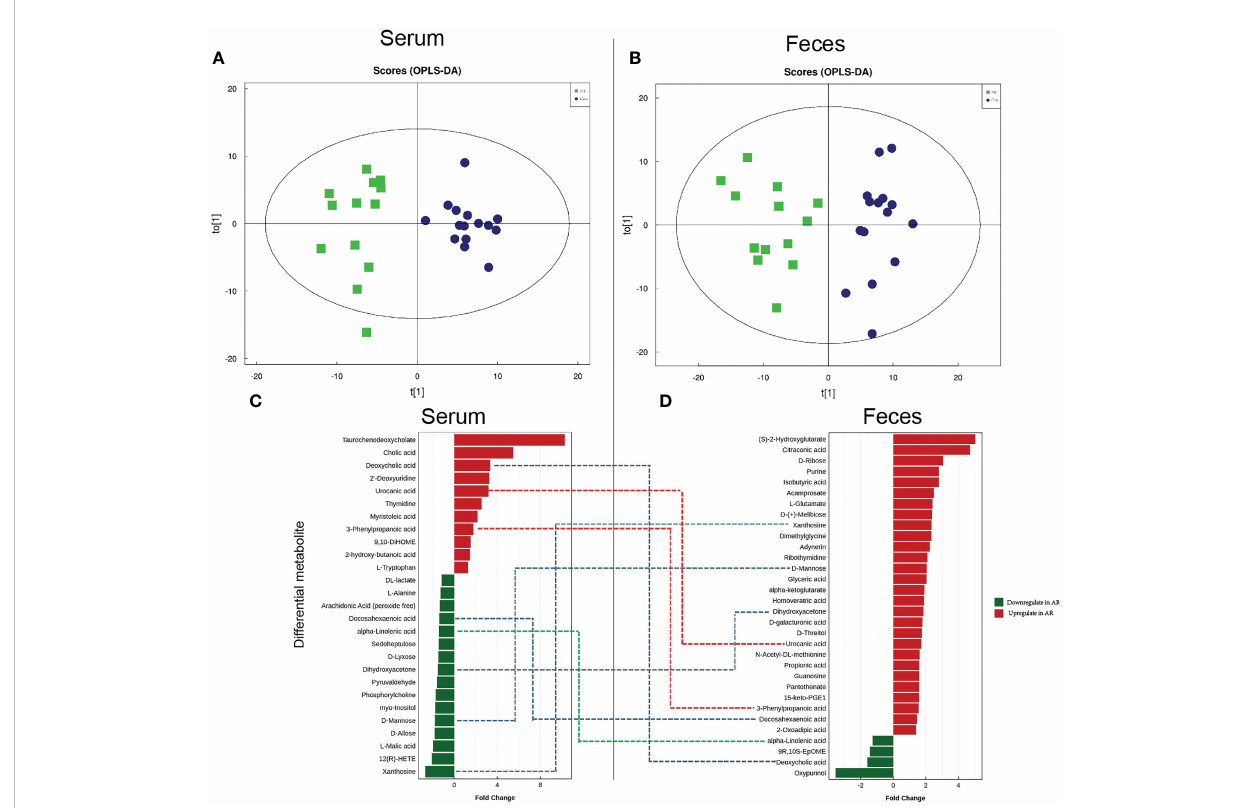
FIGURE 6 Characteristics of metabolomics in serum and feces. OPLS-DA score plots in serum metabolomics (A) and fecal metabolomics (B) . Dots of the same color represent each biological repetition in the group, and the distribution state of dots re fl ects the difference between and within the group; Histogram of signi fi cant differential serum metabolites (C) and fecal metabolites (D) . The red histogram shows the metabolites that are signi fi cantly elevated in the AR group (Fold change >1). The green histogram shows the signi fi cantly reduced metabolites in the AR group (fold change>1). In the middle of Figure 6C and Figure 6D, the red dotted line represents the metabolites increased in feces and serum, the green dotted line represents the metabolites decreased in feces and serum, and the blue dotted line represents the metabolites increased or decreased inconsistently in feces and